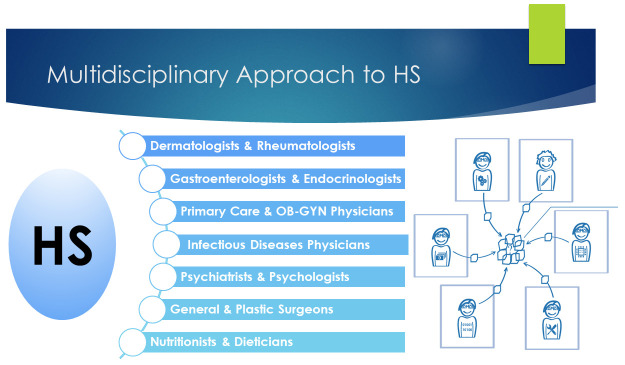
A multidisciplinary approach to hidradenitis suppurativa.